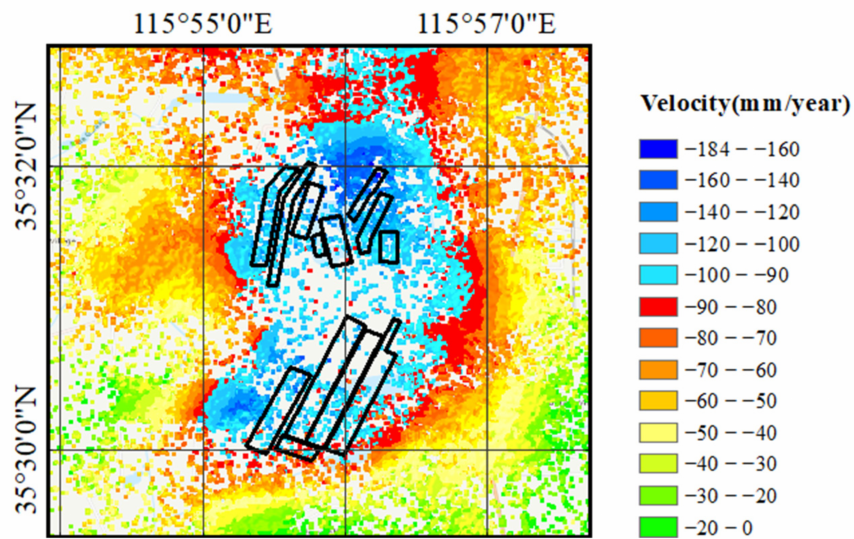
Figure 4. The average annual subsidence rate of the mining area monitored by SBAS-InSAR.